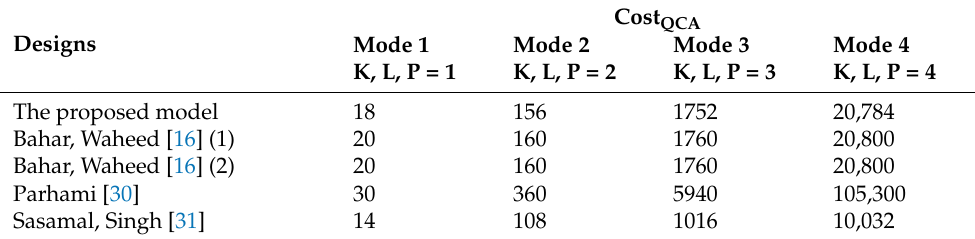
Table 4. QCA cost for the proposed reversible double Feynman gate and other